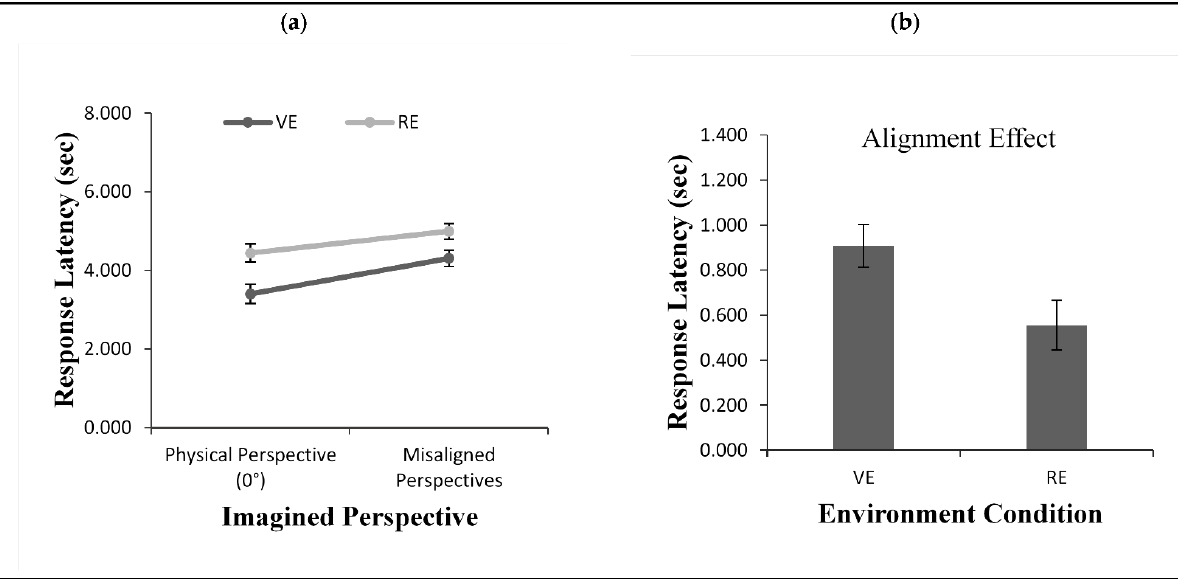
Figure 3. Response Latency ( a ) as a function of imagined perspective and alignment effect for response latency ( b ) across environment conditions (VE vs. RE) in Experiment 1. Error bars represent standard errors from the ANOVA and from a t -test, respectively.